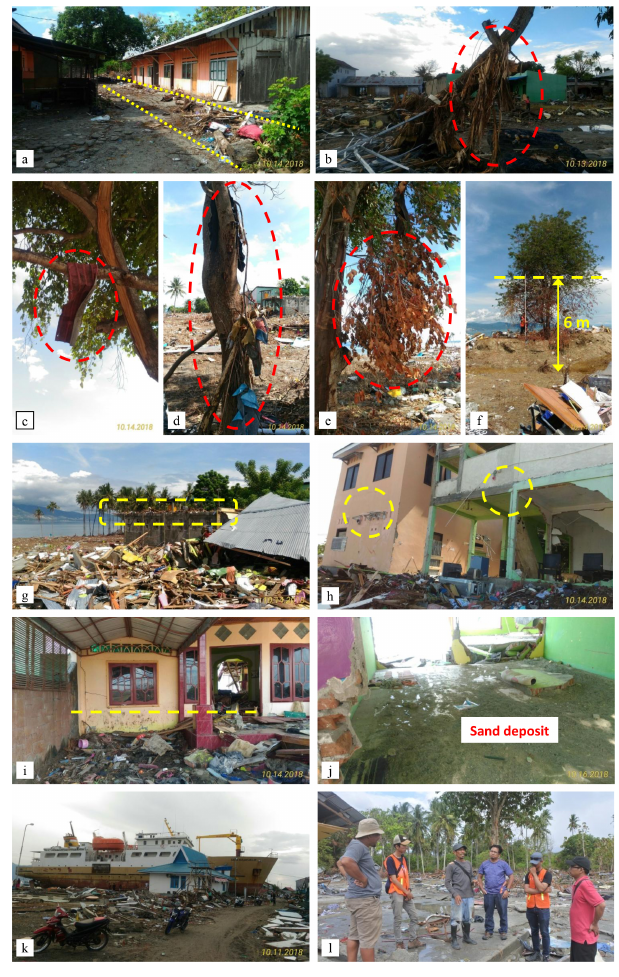
Figure 2. Evidence of tsunami run-up and inundation. (a) Debris left behind in the residential area of Tondo, (b) debris caught in a tree in Mamboro, (c) and (d) debris stuck in a tree in Tondo, and (e) leaves turned brown due to being submerged in saltwater. (f) A tree had green leaves at the top and brown at the lower part, indi- cating the tsunami inundation height (flow depth) limit in Layana. (g) Debris lodged on top of a building, (h) broken house element showing tsunami water level, (i) watermark on a house wall in Lero Village, (j) sand deposit on building floor in Donggala City, (k) a 45m long ship moved to land in Wani Harbor, and (l) interview with a survivor in